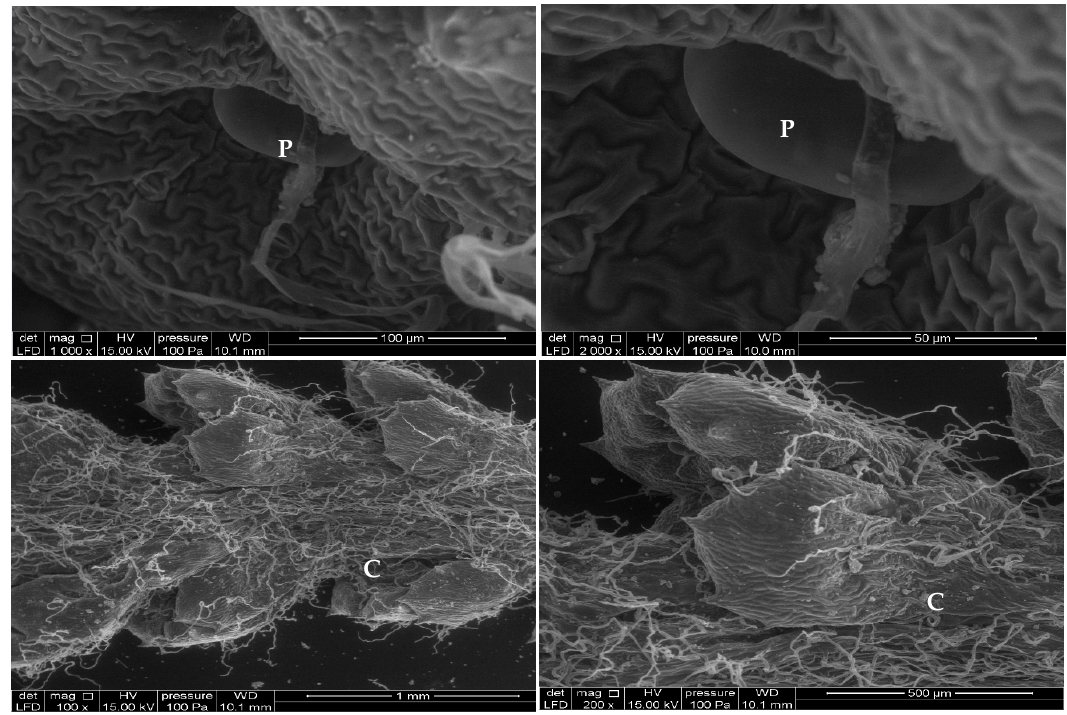
Peltate gland; C, Distribution of trichomes on the leaf).